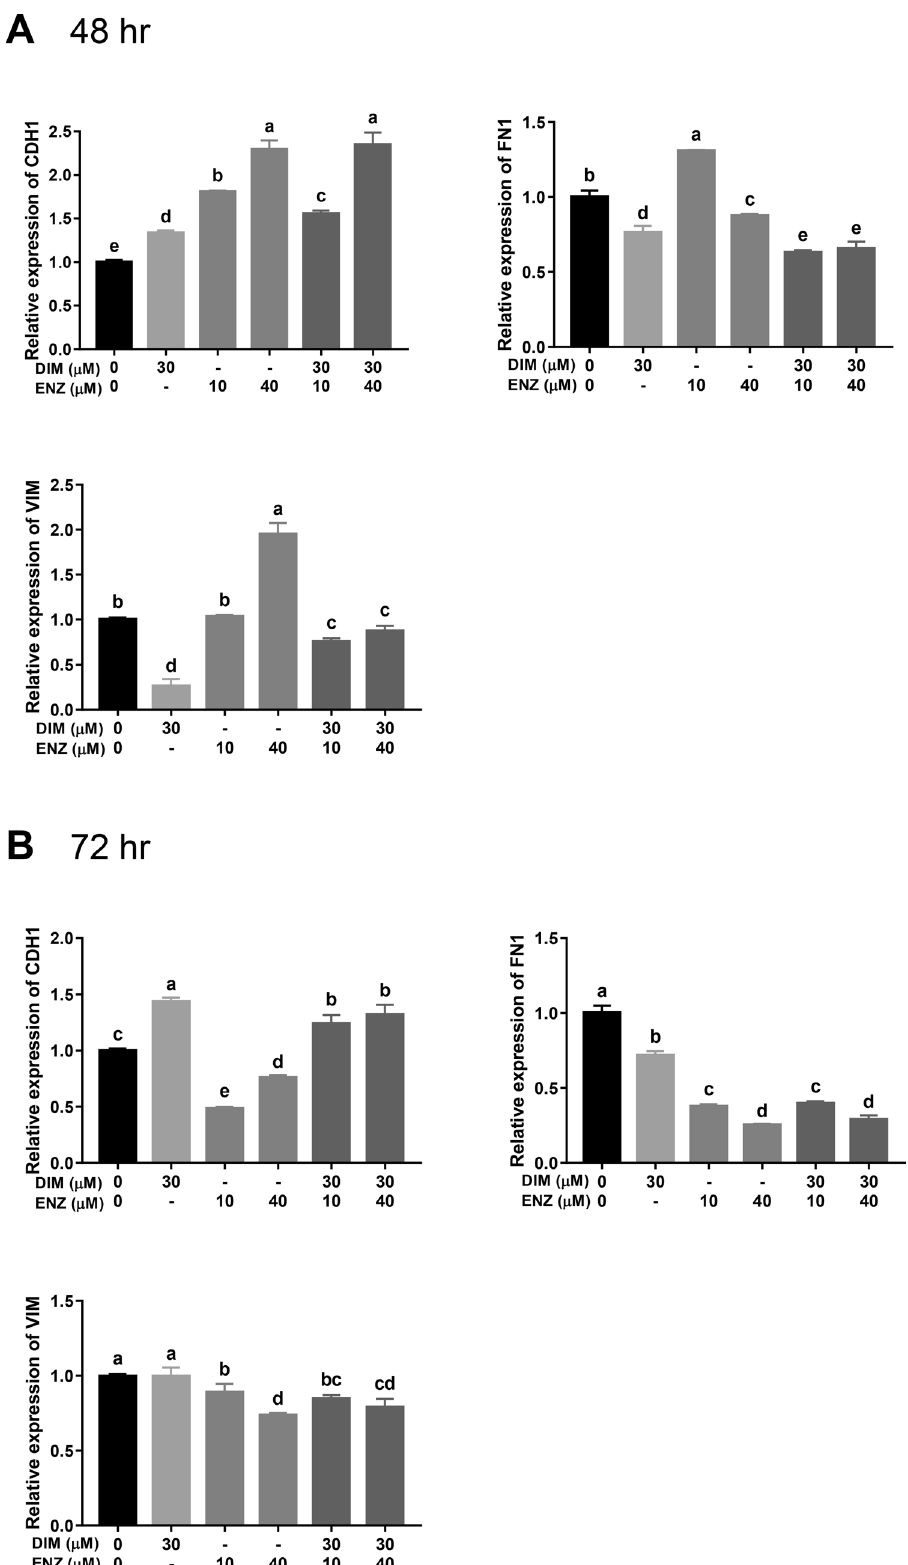
Figure 8. DIM and ENZ treatment alter EMT-related gene expressions in 22Rv1 cells at 48 ( A ) and 72 ( B ) h (n = 3). DIM 3,3 ′ -diindolylmethane; ENZ enzalutamide; VIM Vimentin; FN1 Fibronectin; CDH1 E-cadherin. a,b,c,d Bars without the same letters at the top indicate statistically-significant differences between treatments when compared with each other (one-way ANOVA, Duncan’s new multiple range test, p <